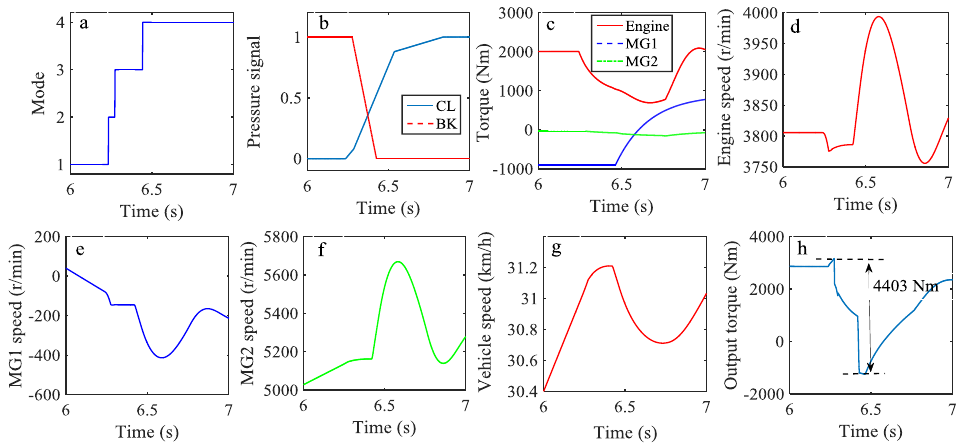
Figure 15. Mode shift characteristics of the hybrid HDV: ( a ) mode; ( b ) pressure signal; ( c ) torques of engine and MGs; ( d ) engine speed; ( e ) MG1 speed; ( f ) MG2 speed; ( g ) vehicle speed; and ( h ) output torque.